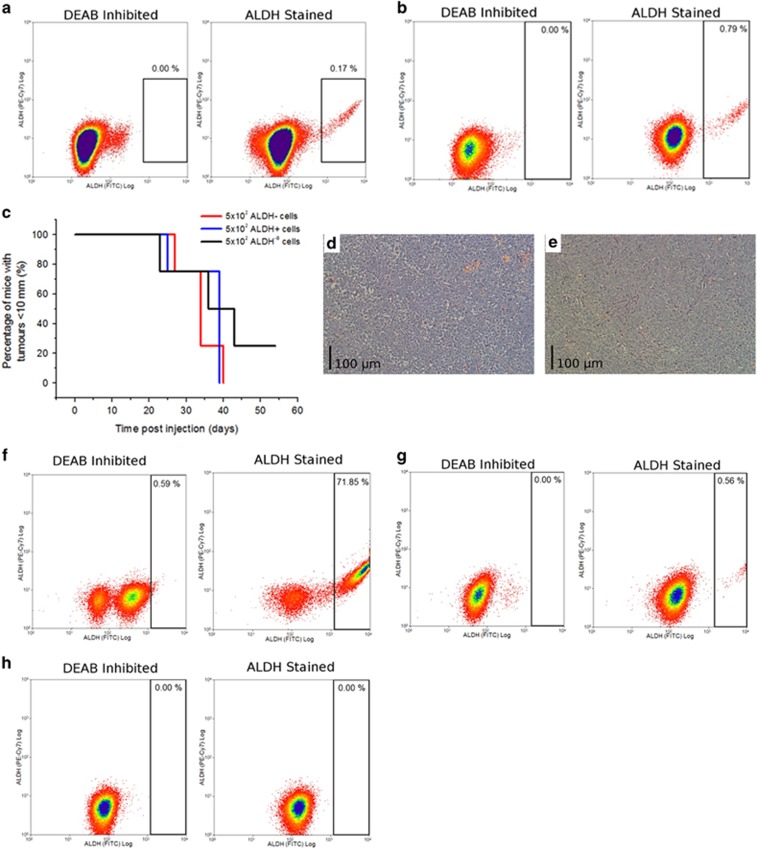
Identification of a novel ALDH ovCSC. The cisplatin-sensitive, treatment-naive cancer model A2780 and its cisplatin-adapted counterpart A2780cis were screened for the presence of putative CSC populations based on the expression of CD44, CD113, CD117 and CXCR4, as well as Hoechst efflux capacity (Side Population assay) and ALDH activity (Supplementary Data 1). Both cell types contained a population with strong ALDH activity (a): A2780, (b): A2780cis, flow cytometry using ALDH inhibitor DEAB as a negative control. ALDH+ and ALDH− cells were isolated from the A2780 model by FACS and found to efficiently generate xenograft tumours in vivo (c), n=4 for each cell type that were confirmed as representative of ovarian cancer by pathological analysis (H+E staining, (d): ALDH+, (e): ALDH−). Cells of each type were plated singly, allowed to develop into colonies and then assessed for the presence of ALDH+ and ALDH− cells (SCAD assay). (f) SCAD assays demonstrated that ALDH+ cells could produce ALDH+ and ALDH− cell types, validating them as CSCs, n=4. (g) Some ALDH− clones (termed ALDH−A, n=4) were found to generate both cell types, validating them as CSCs also. (h) However, other ALDH− clones (termed ALDH−B, n=6) were found to produce only ALDH− cells. When isolated by FACS, ALDH−B cells were also found to efficiently generate xenograft tumours in vivo (c). Similar results were generated for the A2780cis model (Supplementary Data 1).These data indicated the presence of a complex CSC network, the elucidation of which required identification of a second marker, a process that is described in Supplementary Data 2. All experiments were conducted in three biological replicates and statistical significance was determined as described in Materials and Methods section